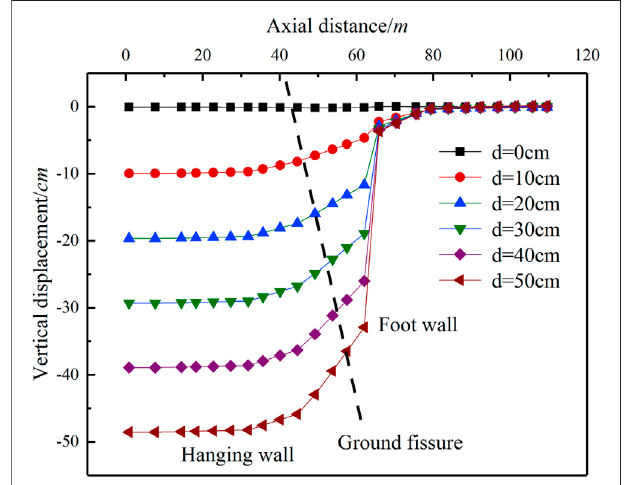
FIGURE 7 | Structural deformation curve of underground utility tunnel obliquely crossing the ground fi ssure (inclination 64 ° ).